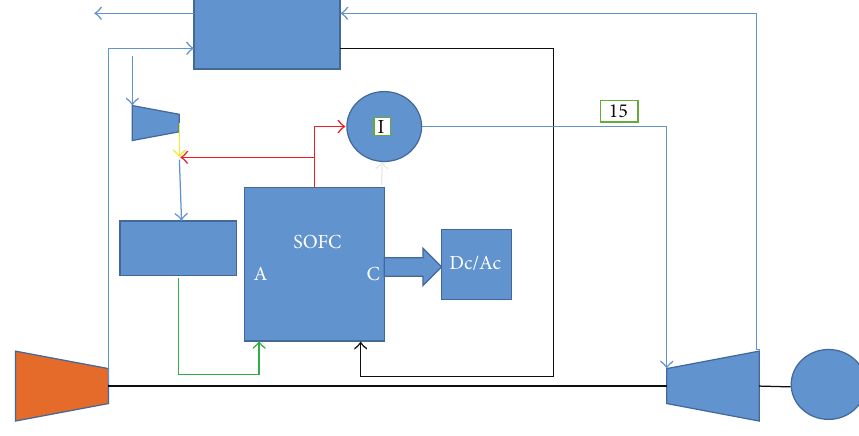
Figure 3: Technical scheme of complete system.